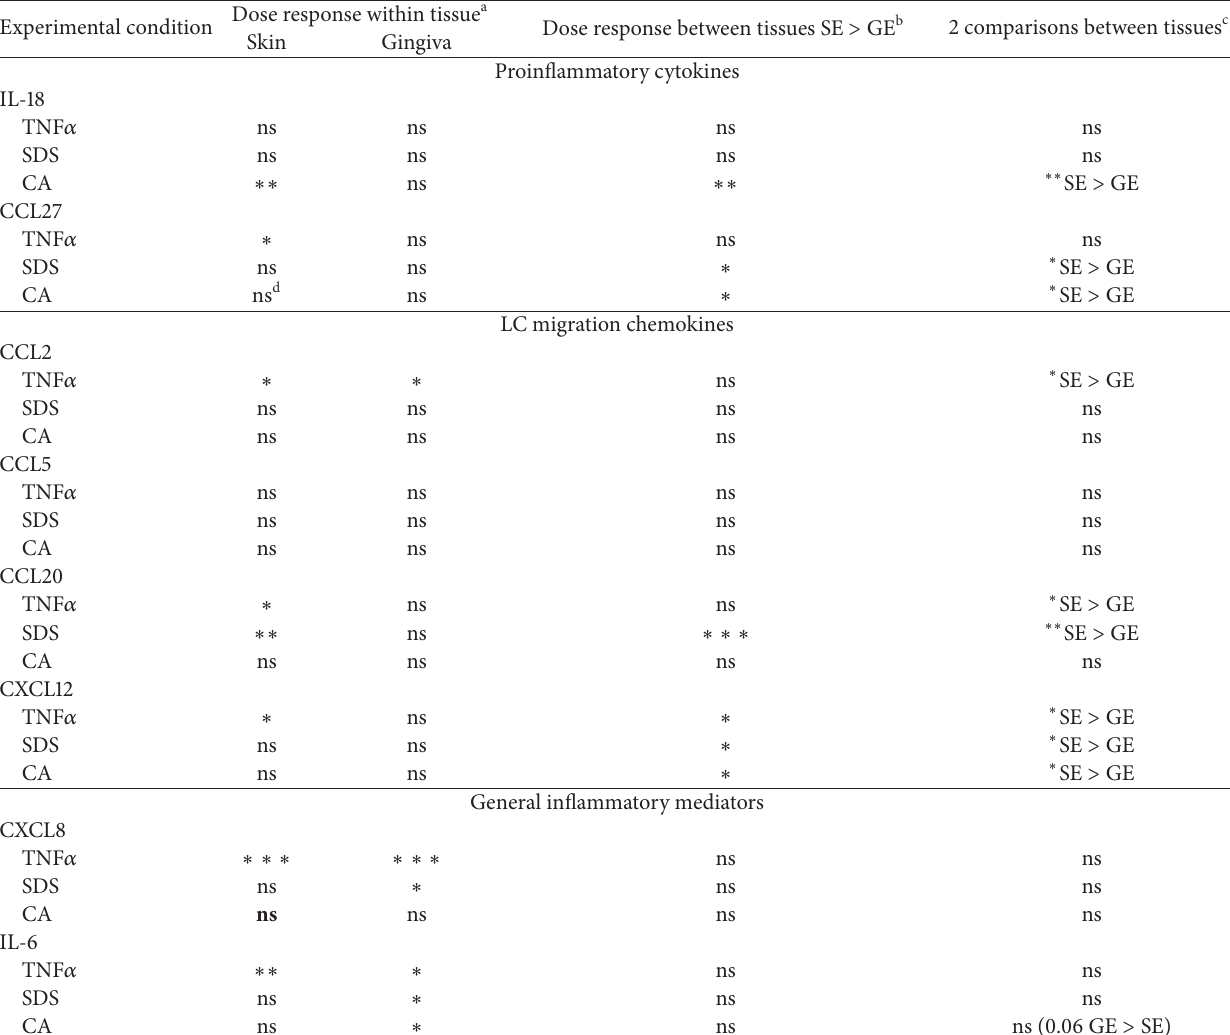
Table 1: Summary of results obtained after exposing skin and gingiva tissue equivalents to TNF 𝛼 , an allergen (CA), or an irritant (SDS). Dose response within tissue Experimental condition